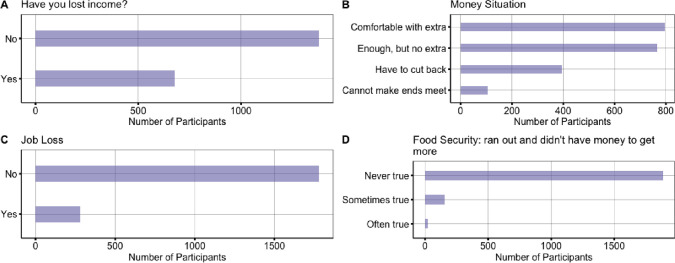
Financial strain.